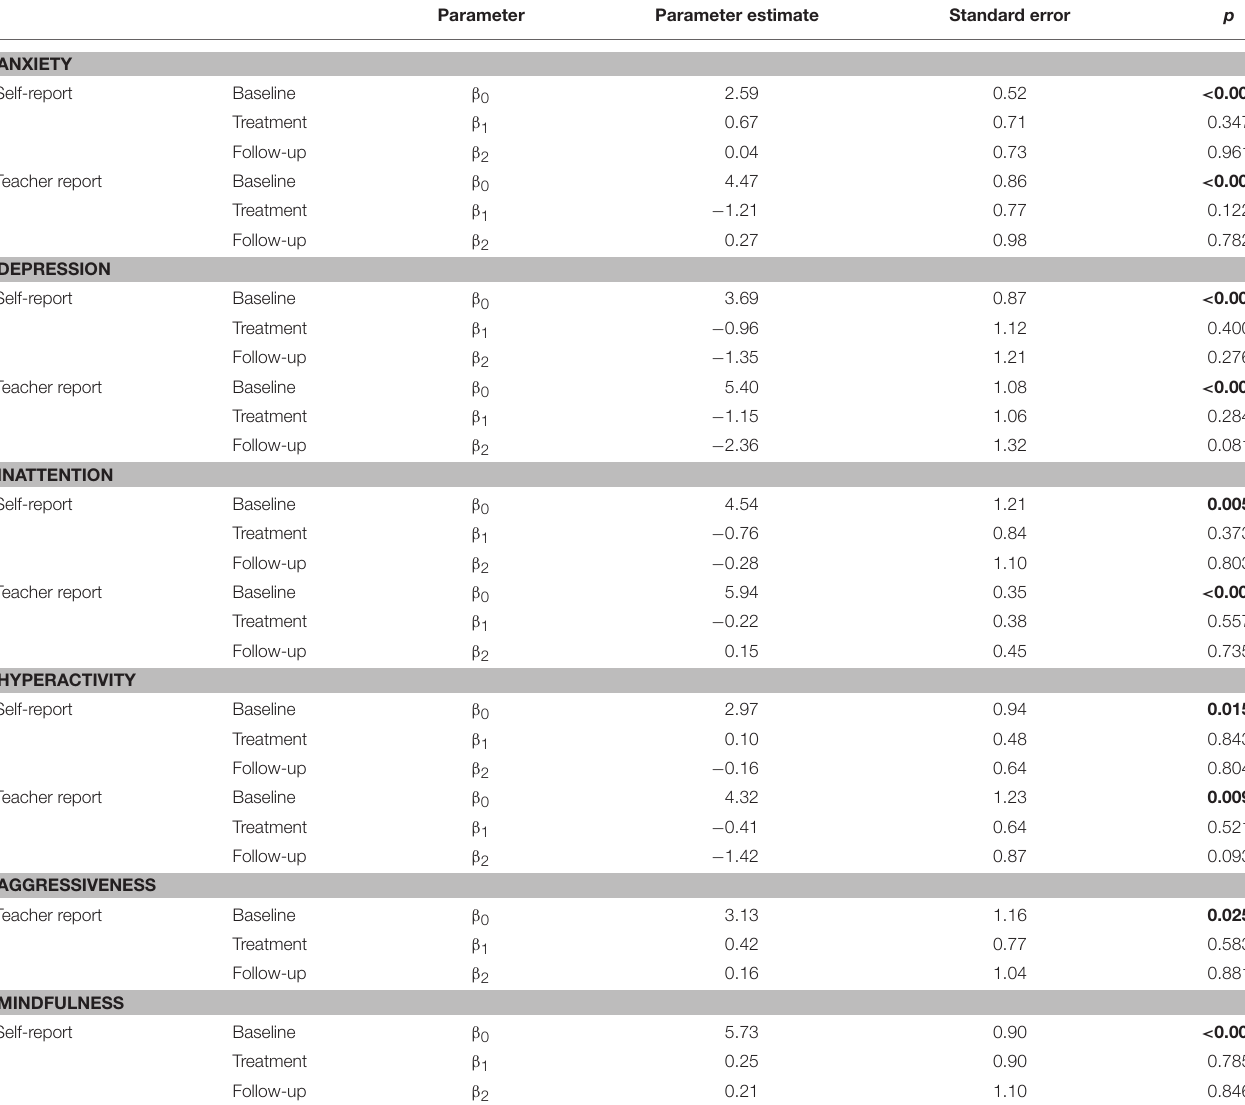
TABLE 4 | Results of empirical estimations of the case-specific effects using the basic three level model for all variables for Group B